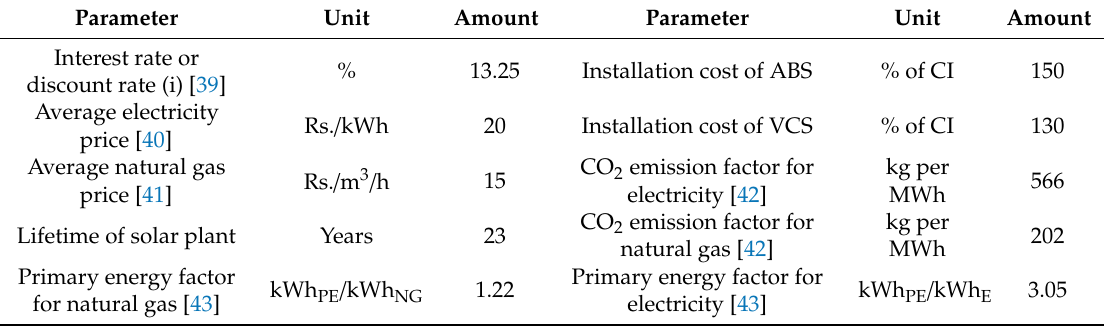
Figure 7. ( a ) Comparison of collector efficiency curve (simulation vs. experimental data reported by the collector’s manufacturer at G = 1000 W/m 2 ); ( b ) daily temperature and humidity variation for Lahore, Pakistan. Table 5. Parameters considered for energetic, economic and environmental (3E) analyses in this study.